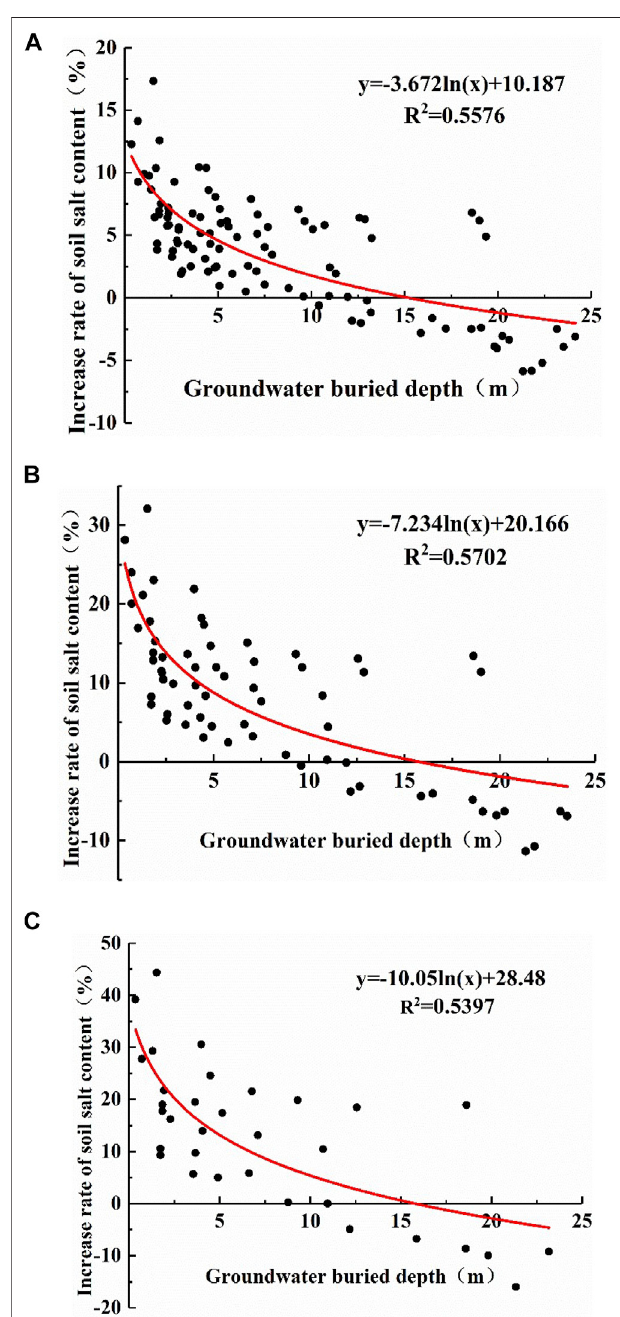
FIGURE 6 | Relationship between the increase rate of the soil salt content and the groundwater buried depth at different years intervals [ (A) fi ve yeas interval; (B) ten years interval; (C) fi fteen years